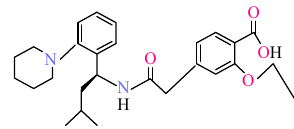
Figure 5: The chemical structure of repaginate. Figure 6: The chemical structure of